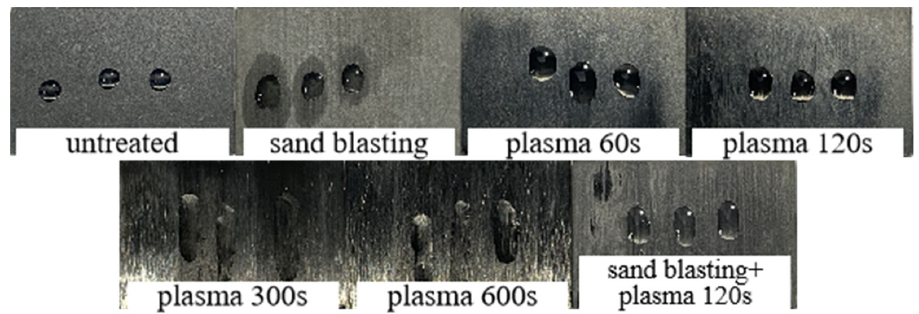
Figure 12. Morphological diagram of ethylene glycol droplets on the surface of CF/EP with different treatment methods.